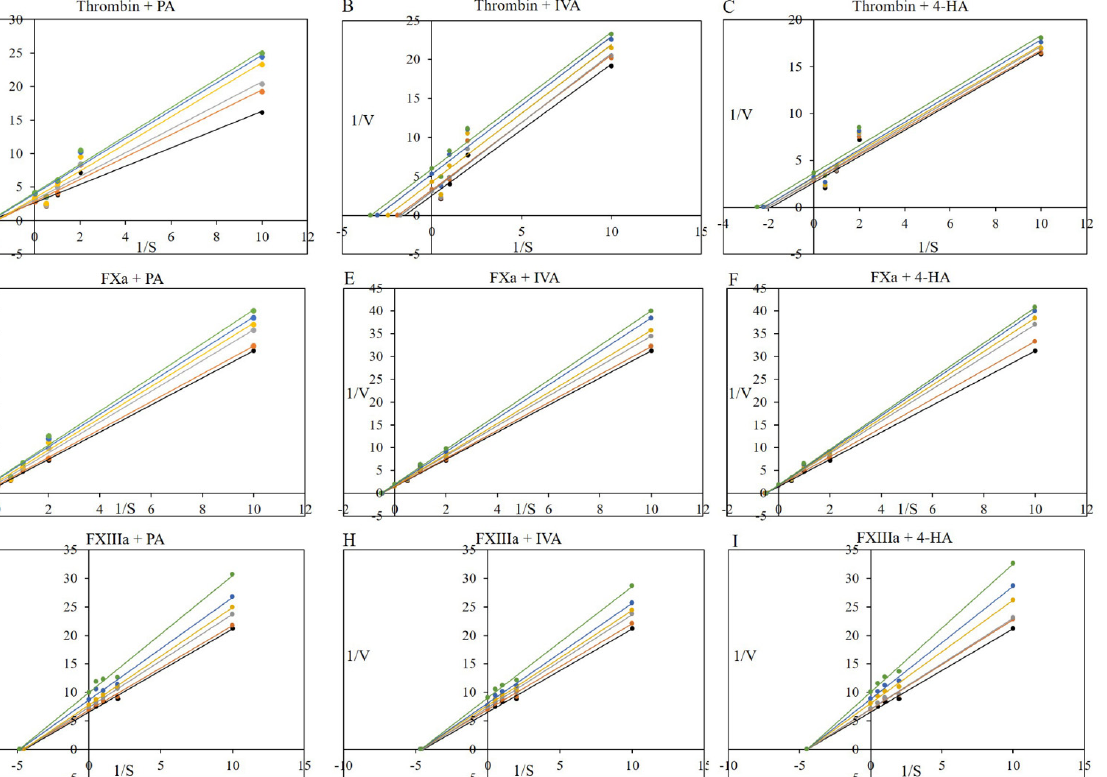
Table 1. Effect of PA, IVA, and 4-HA on kinetic parameters of thrombin.